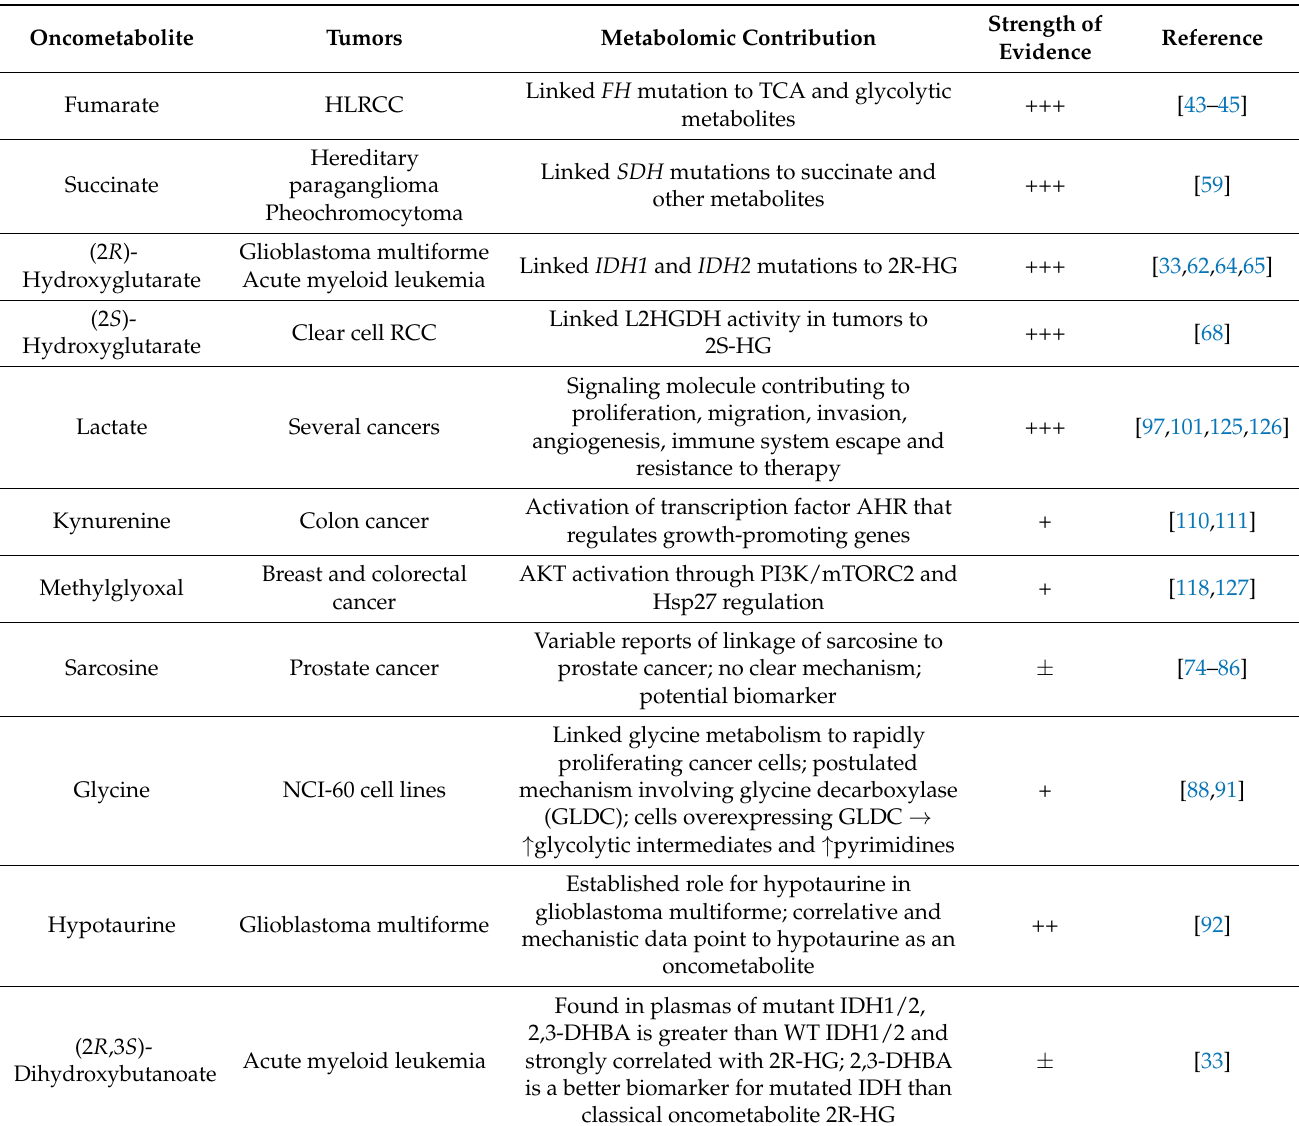
Table 1. Known and putative oncometabolites defined by